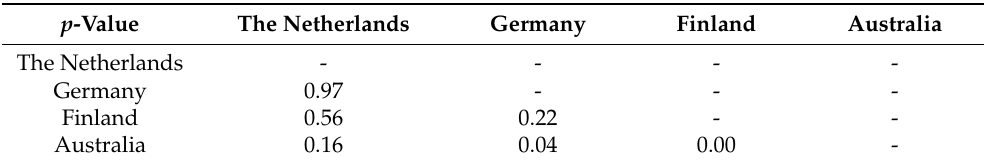
Table 4. Result of the chi-square comparison between countries in the distribution of forest conserva- tion indicators across